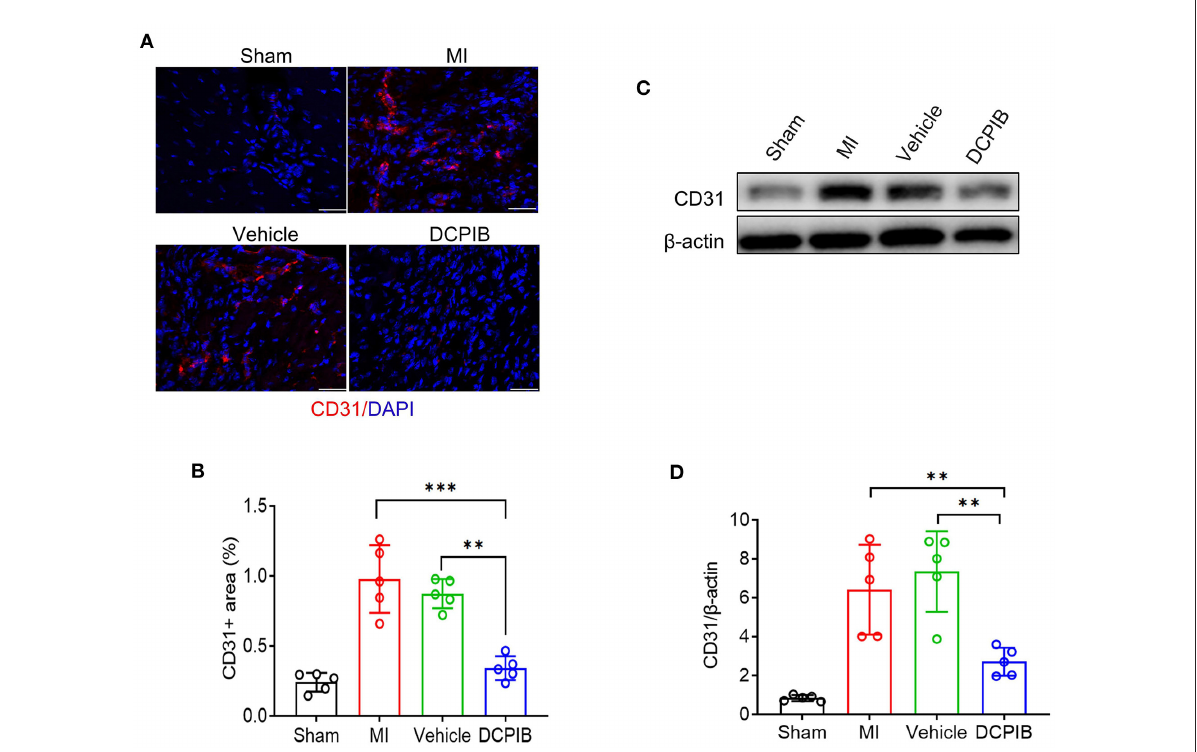
FIGURE2 DCPIB inhibited angiogenesis after MI. (A,B) Representative immunofluorescence and quantitative analysis of the CD31 level in the infarct border zone of the heart tissue of mice treated with DCPIB for 14 days after MI ( n = 5). Red fluorescence represents CD31 and blue fluorescence represents the nuclei (stained by DAPI). Scale bar = 50 µ m. (C,D) Representative western blot and quantitative analysis of CD31 protein level in the heart tissue of MI mice infused with 15 mg/kg/day DCPIB or vehicle for 14 days ( n = 5). ** p < 0.01, *** p < 0.001, ns , no